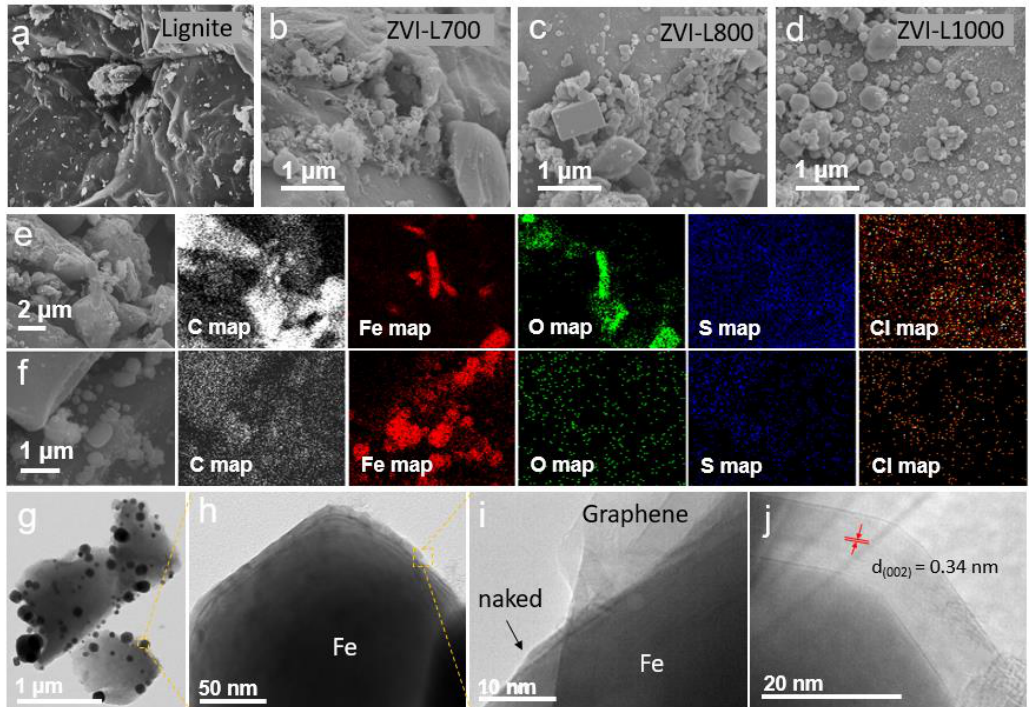
Figure 3. ( a – d ) SEM images of lignite and ZVI-LXs synthesized at 700, 800 and 1000 °C; ( e , f ) SEM images and their corresponding EDX mapping spectra of ZVI-L700 ( e ) and ZVI-L1000 ( f ); ( g – j ) TEM micrographs of ZVI-L1000 showing the distribution of nZVI (dark spheres) in lignite carbon (irregular shaped light color matrix) ( g ), nZVI particle composed of a graphene encapsulation and a metallic iron core ( h ), the imperfect graphene shell with some defects ( i ), the determination of d-spacing of graphene layers ( j ).